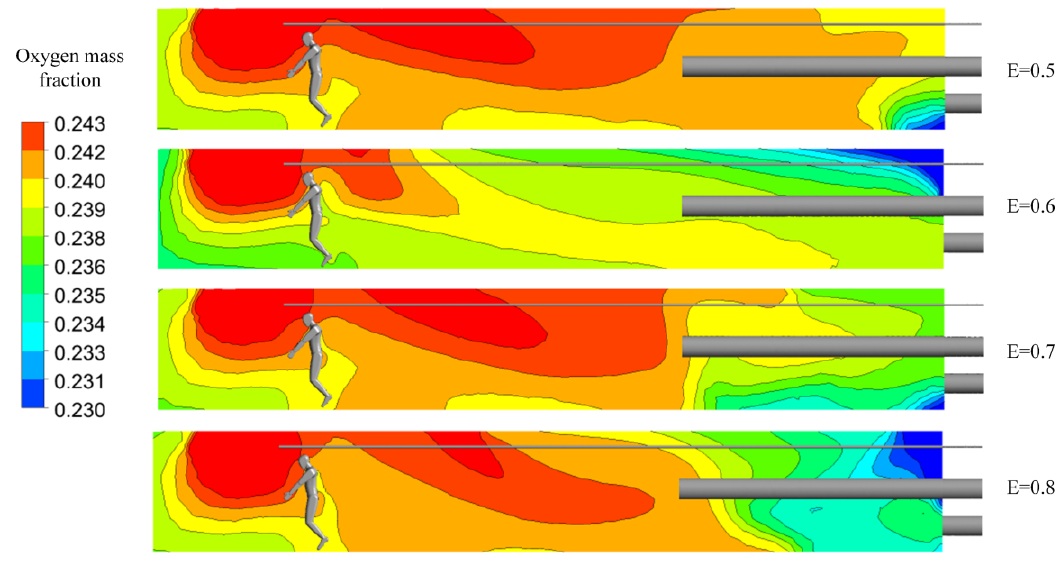
Figure 15. Distributions of oxygen mass fractions at section X = 0 m.